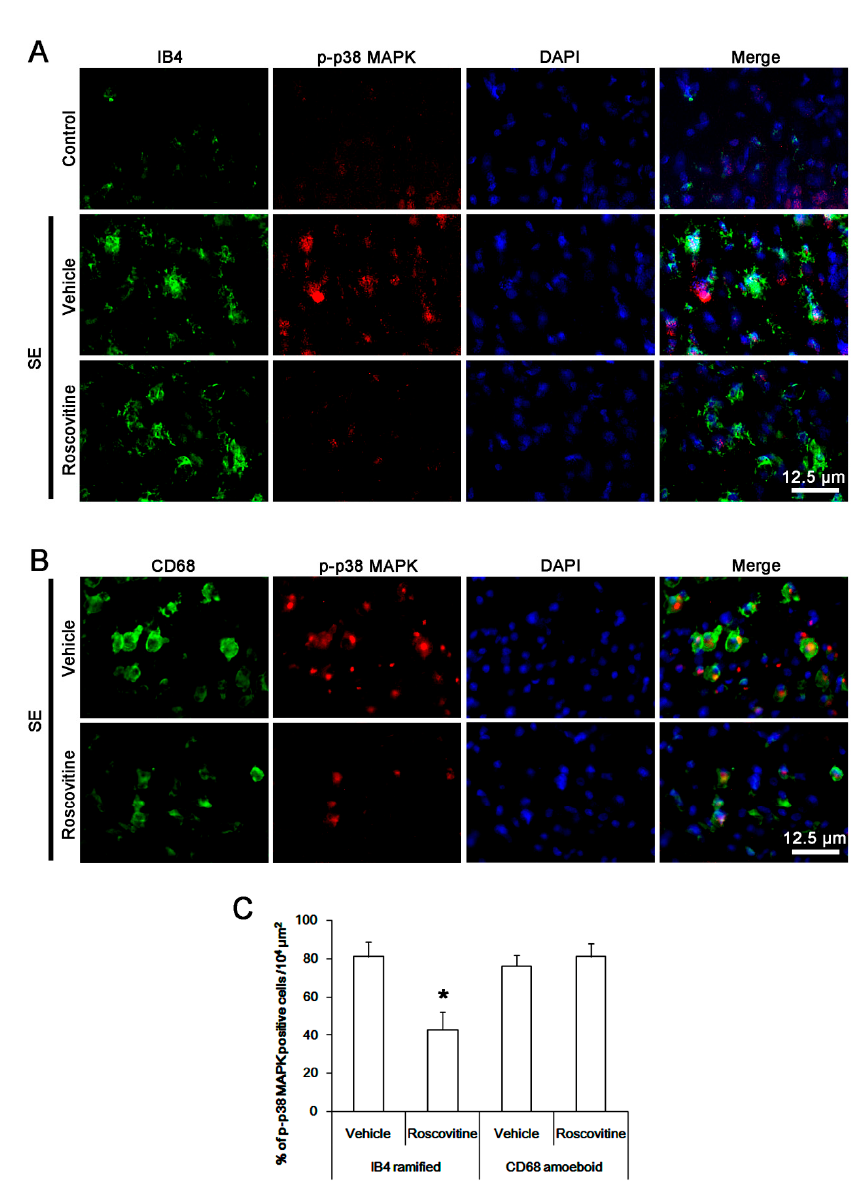
Figure 5. The e ff ect of roscovitine on p38 MAPK phosphorylation in microglia and